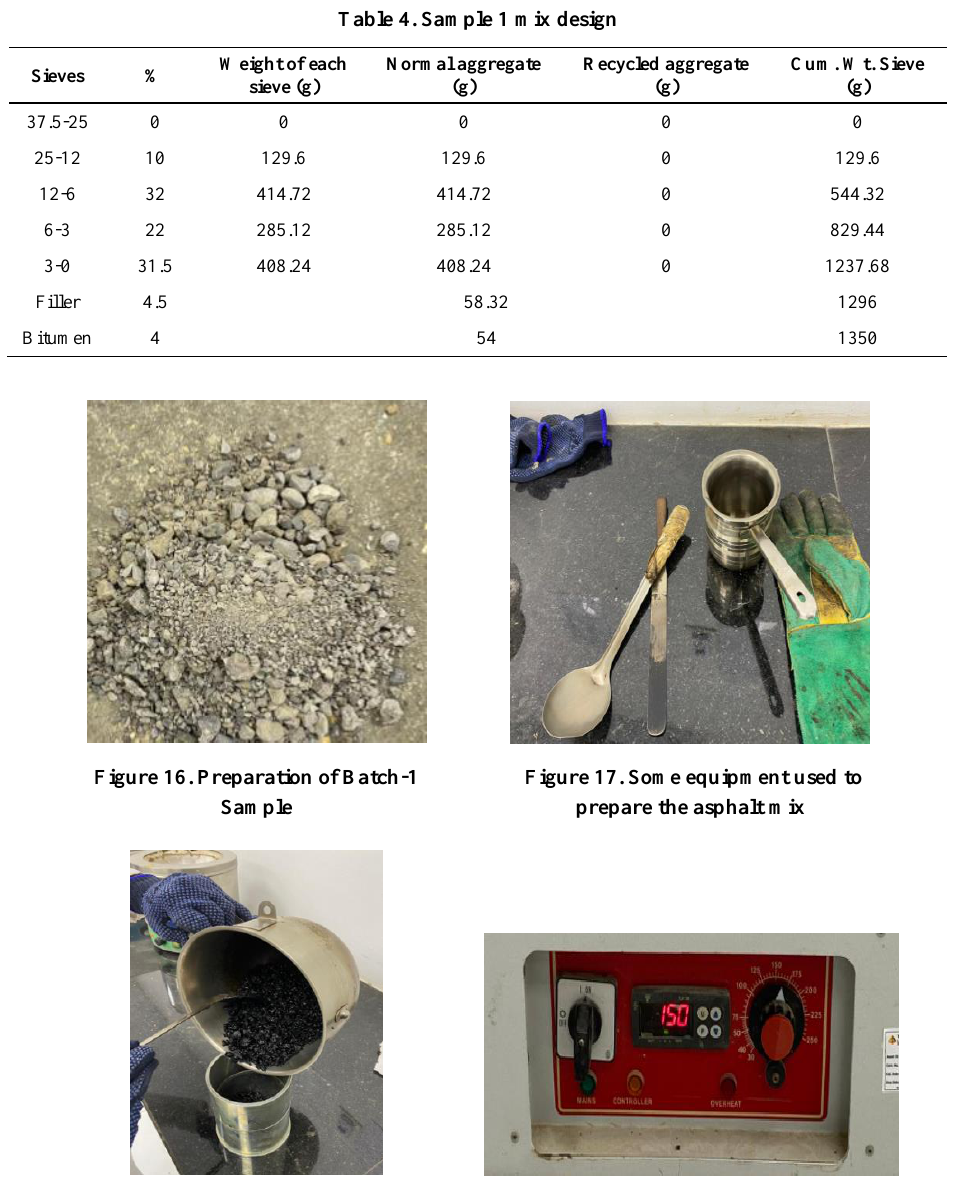
Figure 19. Putting the mould in the drying oven at 155